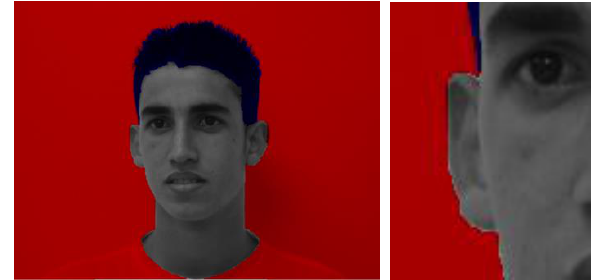
Figure 3. Example of automatic face region segmentation: red region is set of pixels classified as a background